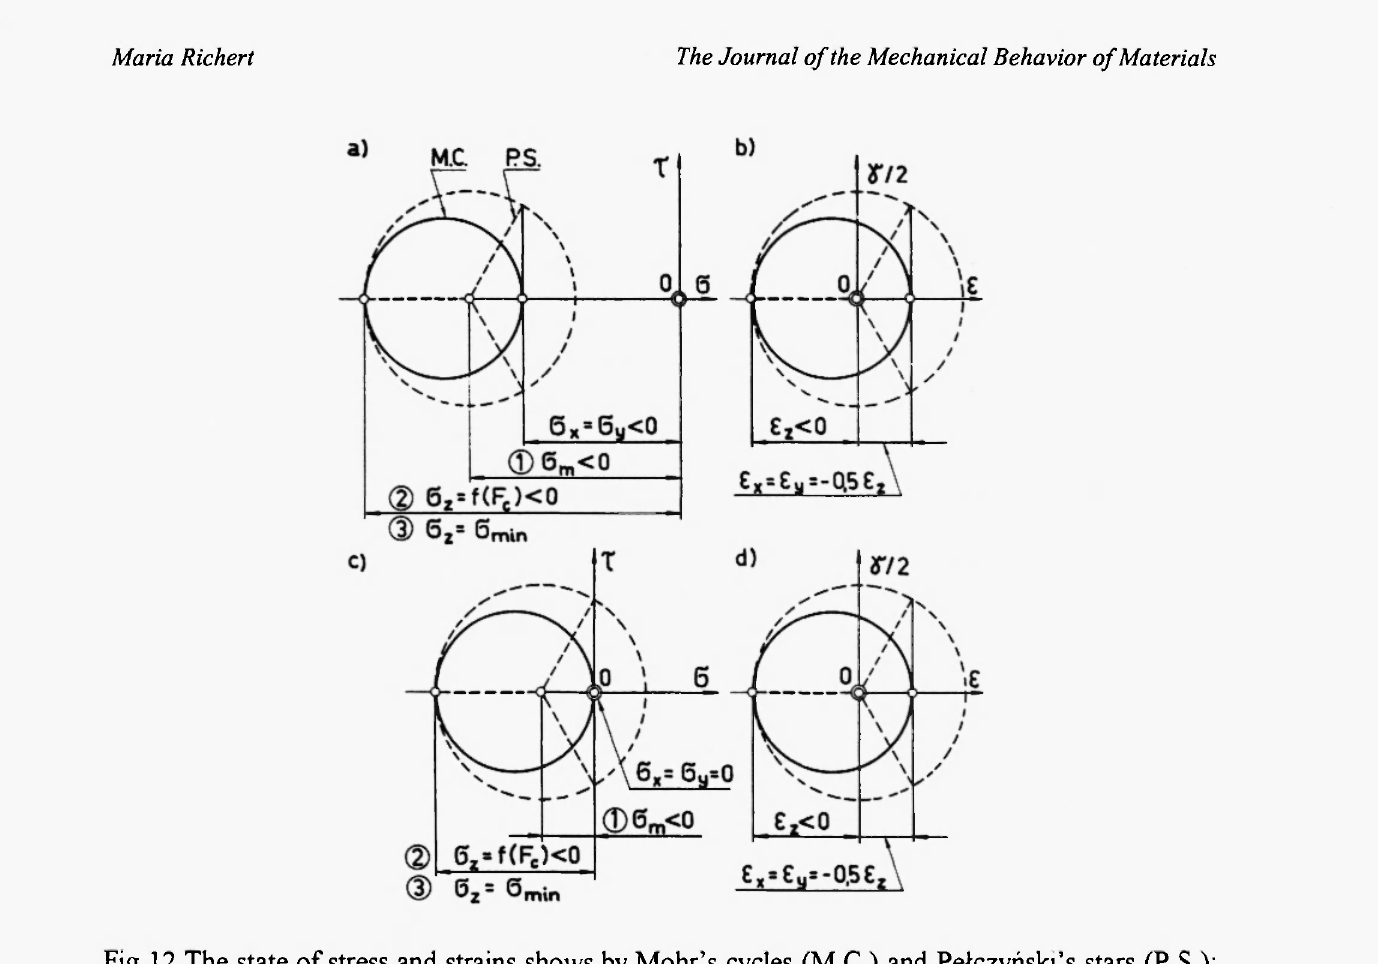
Fig. 12.The state of stress and strains shows by Mohr's cycles (M.C.) and Pelczyhski's stars (P.S.): a)b) - the cyclic extrusion-compression method , c)d) - the compression test.